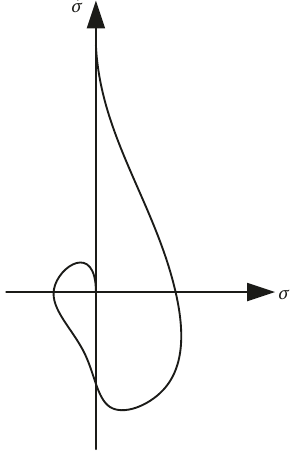
Figure 3: Trajectory of the super-twisting